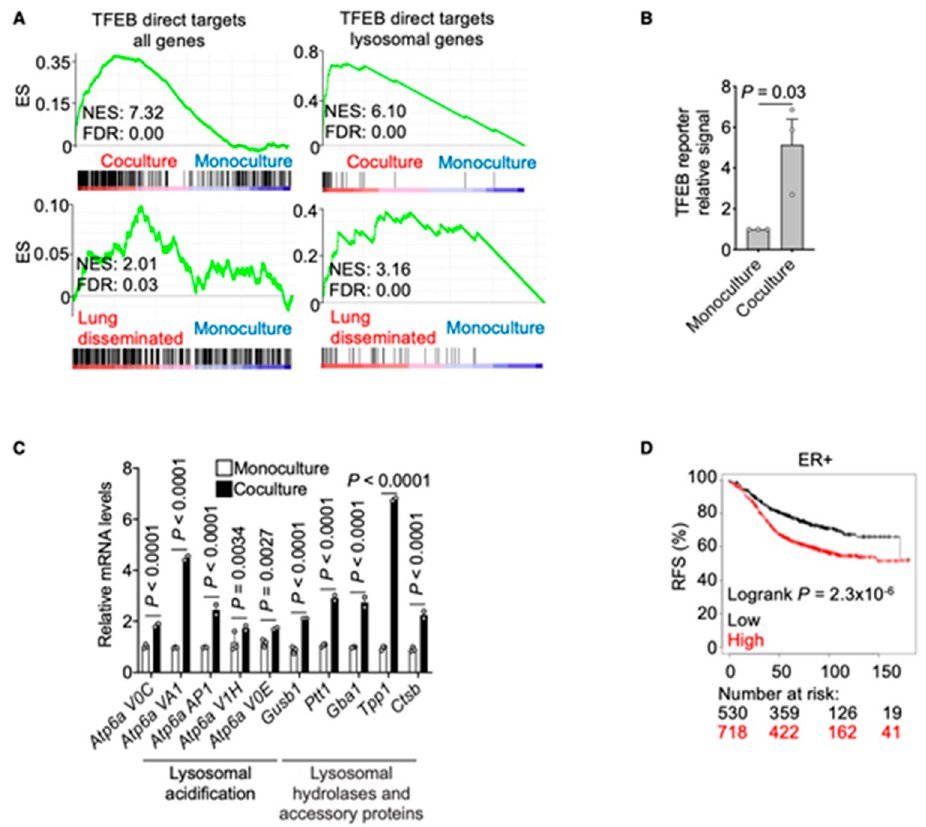
Figure 4. Transcription factor EB (TFEB) transcriptional response is activated in cocultured DDCCs ( A ) Profile of the running ES score for gene sets including TFEB direct targets (all targets or subselection of lysosomal genes, Table S1) after Gene Set Enrichment Analysis (GSEA) of D2.0R-EGFP cells disseminated in vivo, in coculture, or monoculture as indicated. ( B ) Relative induction of transfected TFEB-luciferase reporter in D2.0R-EGFP cells cocultured with AT1-like cells compared to monoculture. n = 3 independent experiments, ratio paired two-tailed t -test, mean with SEM. ( C ) Relative induction of TFEB direct lysosomal targets in D2.0R-EGFP cells cocultured with AT1-like cells compared to monoculture. n = 2–3 independent experiments. Two-way ANOVA, multiple comparisons. ( D ) Kaplan–Meier curve showing Relapse-Free Survival of ER+ breast cancer patients derived from the database at https://kmplot.com/analysis/ (accessed on 27 February 2021), stratified according to the TFEB signature (Table